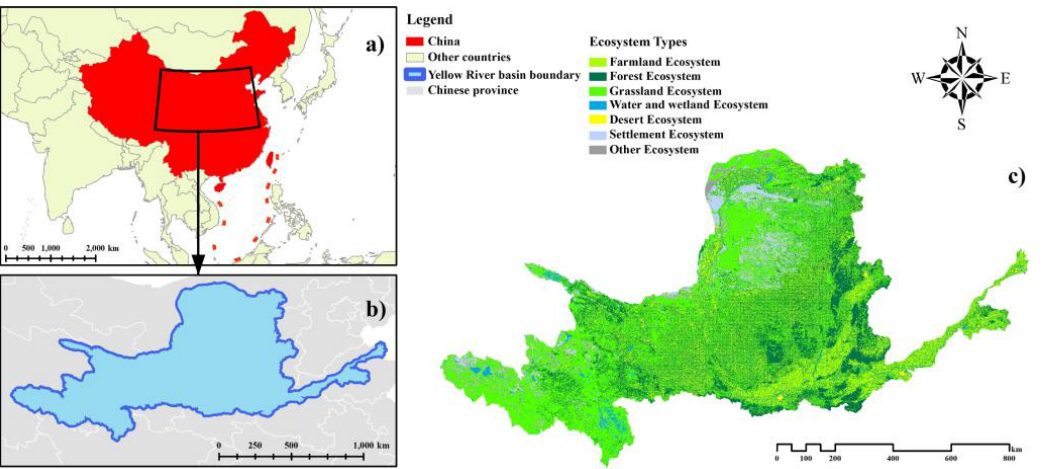
Figure 1. The location of this study area: ( a ) general location of the study area within Eastern Asia, ( b ) location of the study area plotted over a map of the provinces and administrative areas of China, and ( c ) spatial distribution of the ecosystem types in the study area.